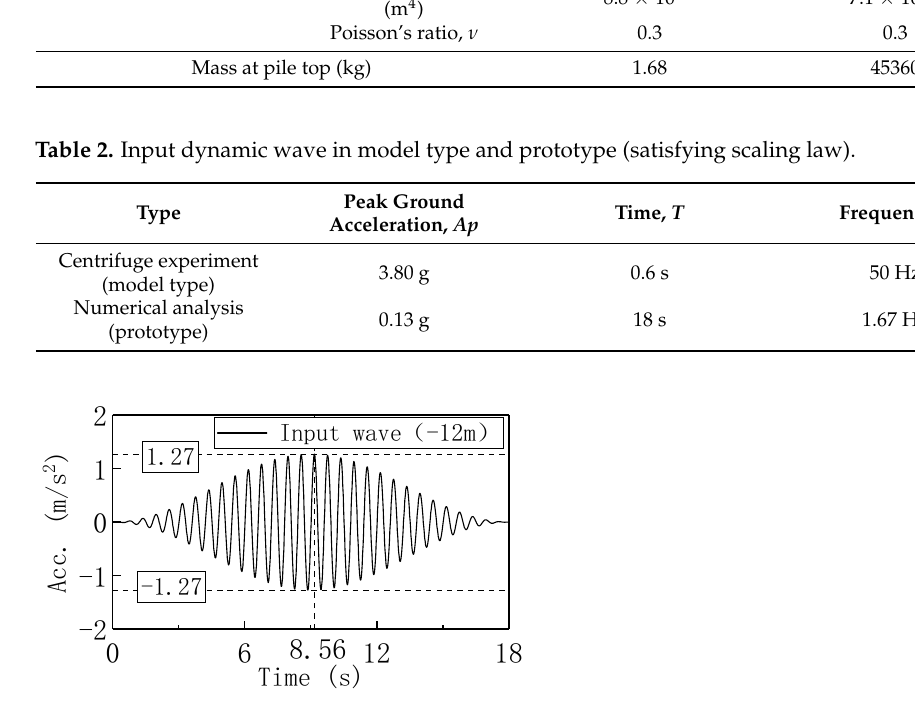
Figure 3. Time history of input dynamic wave.